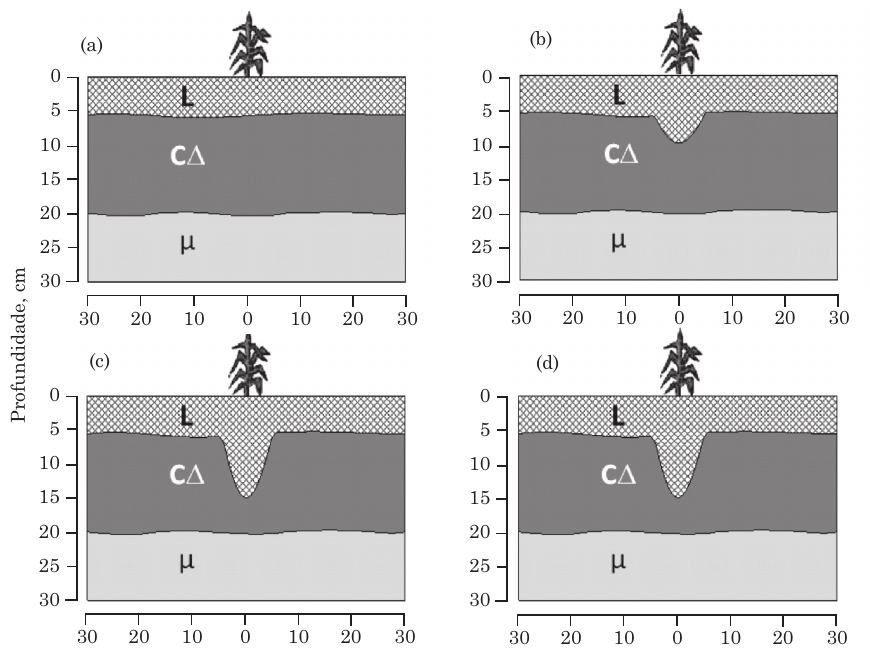
Figura 2. Perfil cultural do Latossolo Vermelho distrófico húmico, aos oito meses após a semeadura de milho ( Zea mays L.), com semeadora equipada com haste sulcadora ajustada para operar a 5 (a), 10 (b), 15 (c) e 17 cm (d) de profundidade. L é a camada de solo solto com macro e microagregados, porosidade visível a olho nu e abundante presença de raízes; C ∆∆∆∆∆ , a camada de solo com estrutura maciça e homogênea, sem porosidade visível a olho nu e menor presença de raízes em relação à camada L; e µµµµµ , a camada de solo com estrutura na forma de grânulos e de blocos, típica de Latossolo